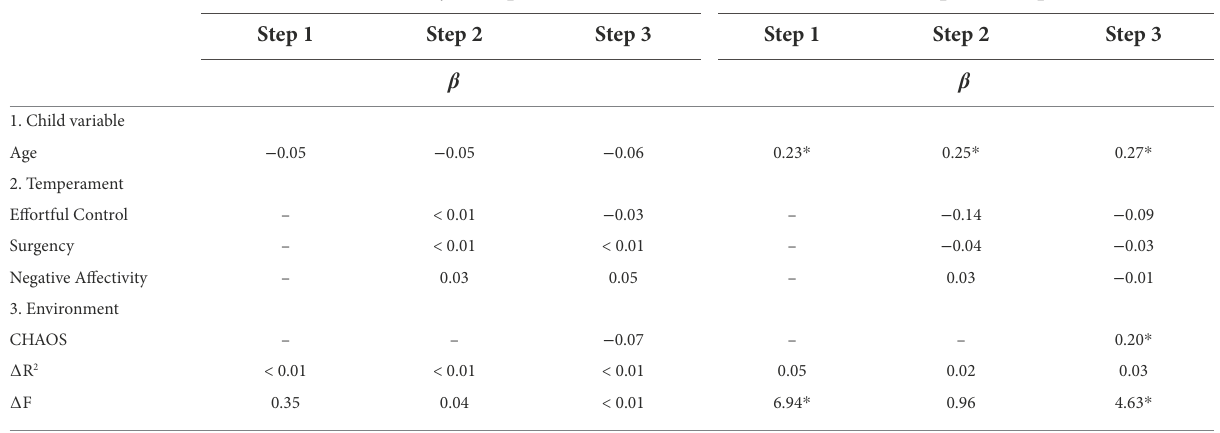
TABLE 8 Regression coefficients for correct anticipations at Time